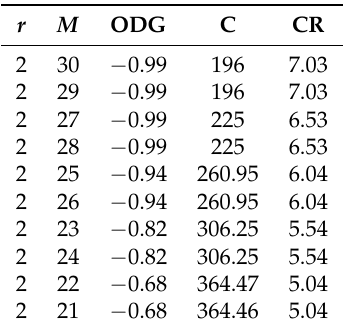
Table 6. 10 highest compression